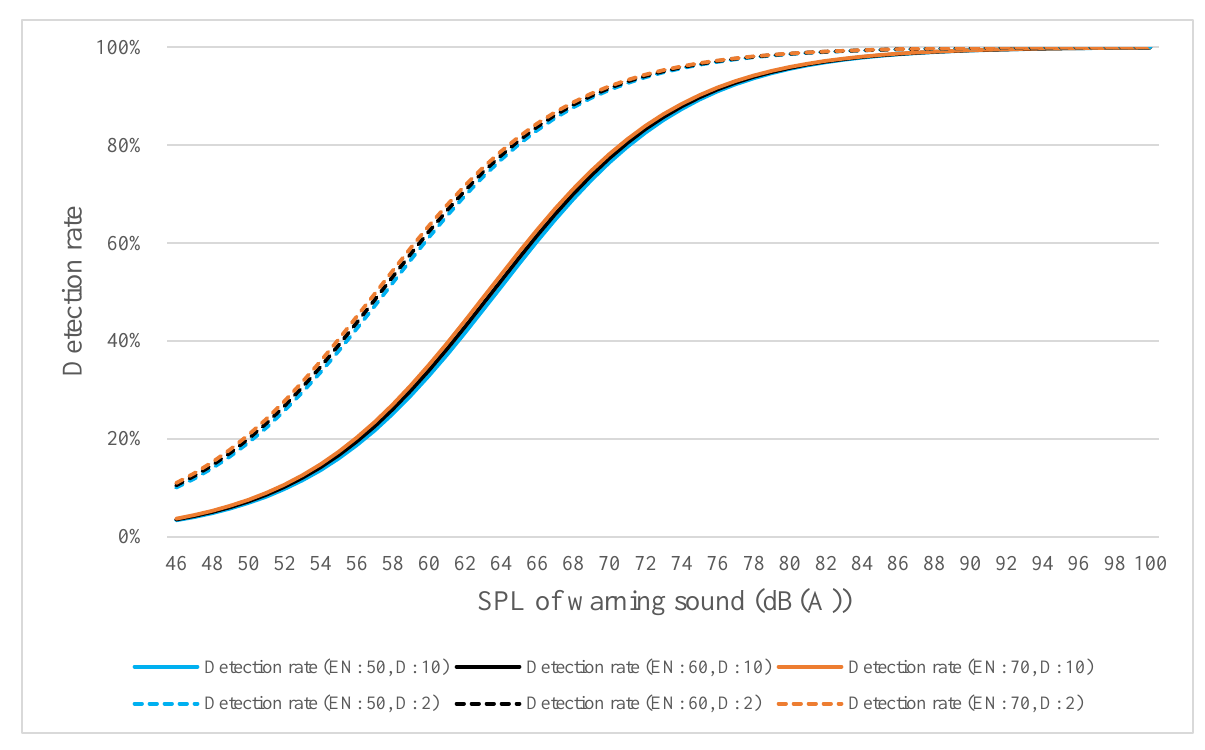
Figure 10. Estimated detection rate for high-frequency warning sound as calculated using Equation (4) (EN denotes environmental noise; D denotes distance).